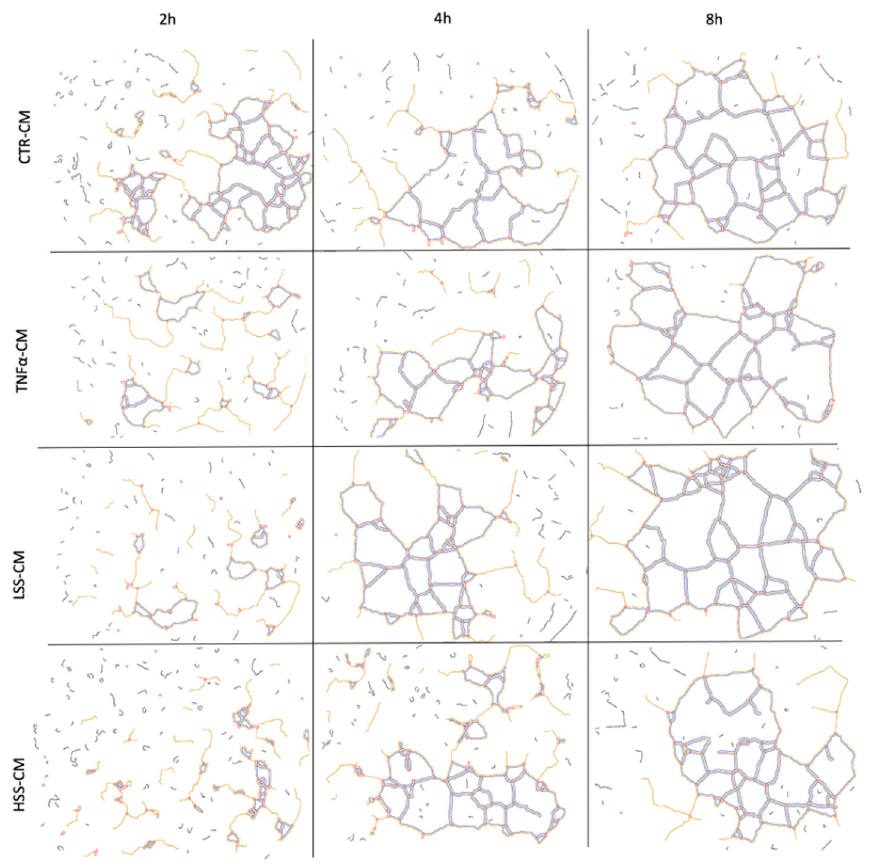
Figure 11. Computer reconstruction obtained in ImageJ Angiogenesis Analyzer plug-in of master segments and junctions observed in HUVECs seeded on Matrigel and stimulated for 8 h with different CMs.